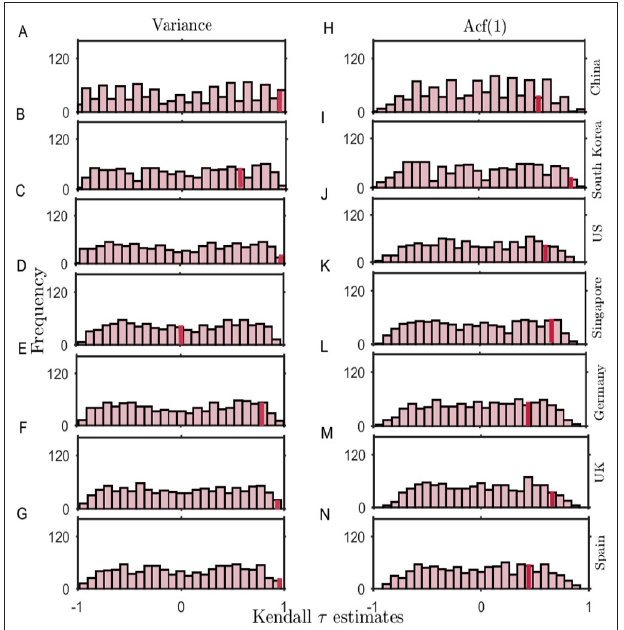
FIGURE 6 | The probability distribution of Kendall- τ test statistic on a set of 1,000 surrogate time series generated by bootstrapping and shuffling (with replacement) the residual time series of the original data. (A-G) : Histograms depict the distribution of the test statistic for the surrogate time series variance (left panels) and (H-N) : autocorrelation function at lag-1 (right panels). Solid lines indicate the limit beyond which the Kendall- τ of the surrogate data is higher than the statistic observed in the ACF(1) of the original time series.